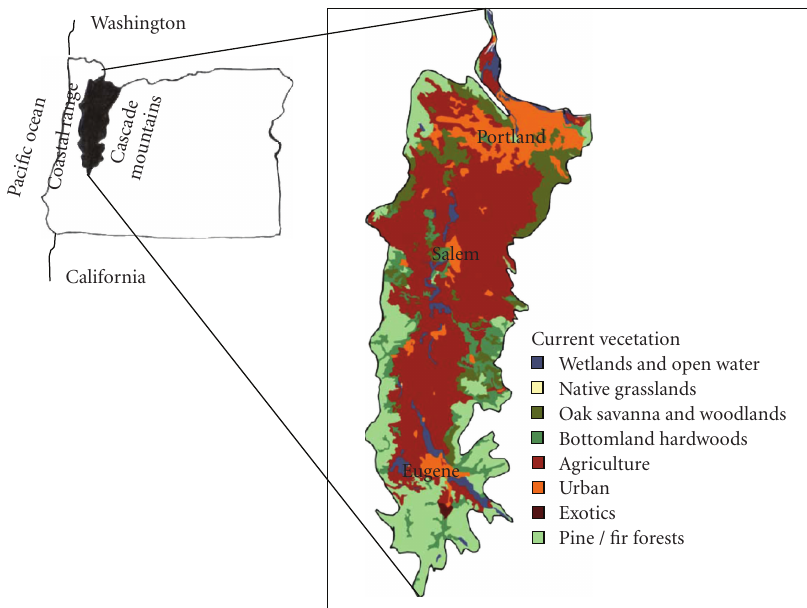
Figure 1: Map of the Willamette Valley in western Oregon showing agricultural, wooded, and urban landscapes (Modified from [11]).